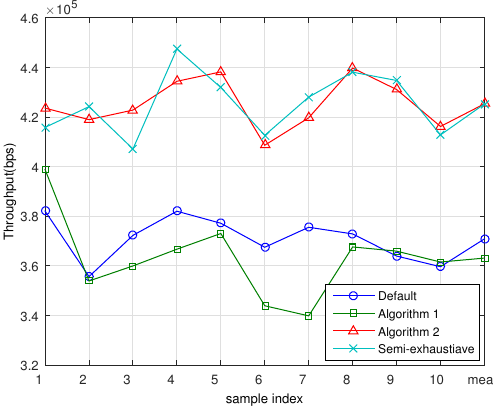
Figure 9. Throughput with different